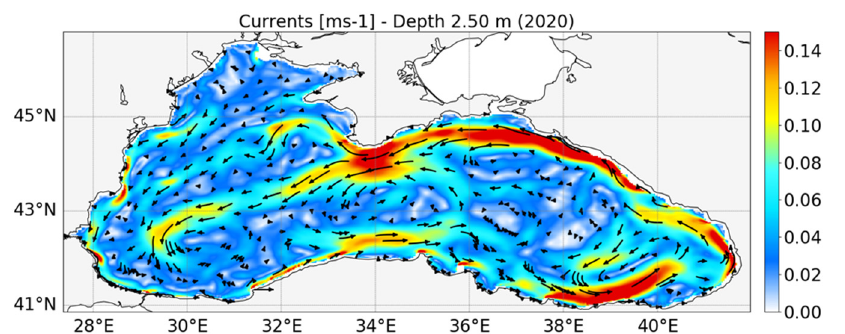
Figure 4. Surface currents in 2020.